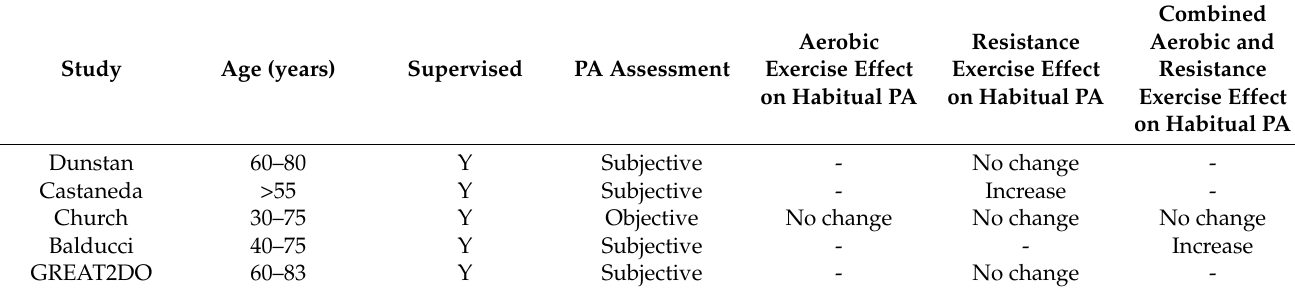
Table 3. Comparison of habitual physical activity (PA) in supervised exercise randomized controlled trials.